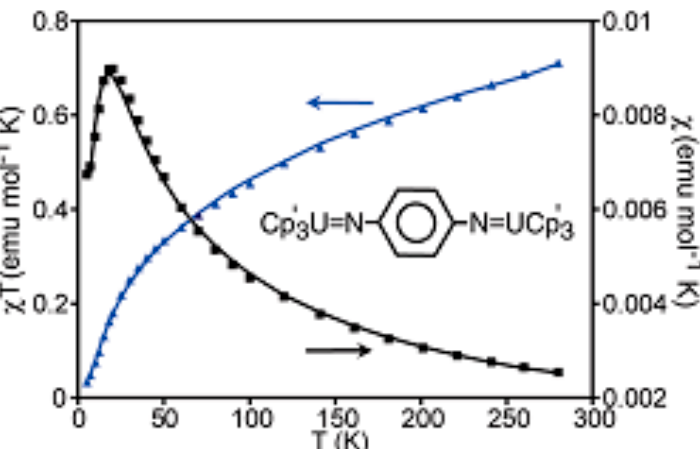
Figure 7. Temperature-dependent magnetic susceptibility χ (black symbols) of [(MeCp) 3 U] 2 (µ-1,4-C 6 H 4 N 2 ) and fits (lines) and the magnetic molar χ T versus T (blue) of the magnetically isolated analog [(MeCp) 3 U] 2 (µ-1,3-C 6 H 4 N 2 ). Susceptibility data (reprinted with permission from [2], American Chemical Society, 2010).